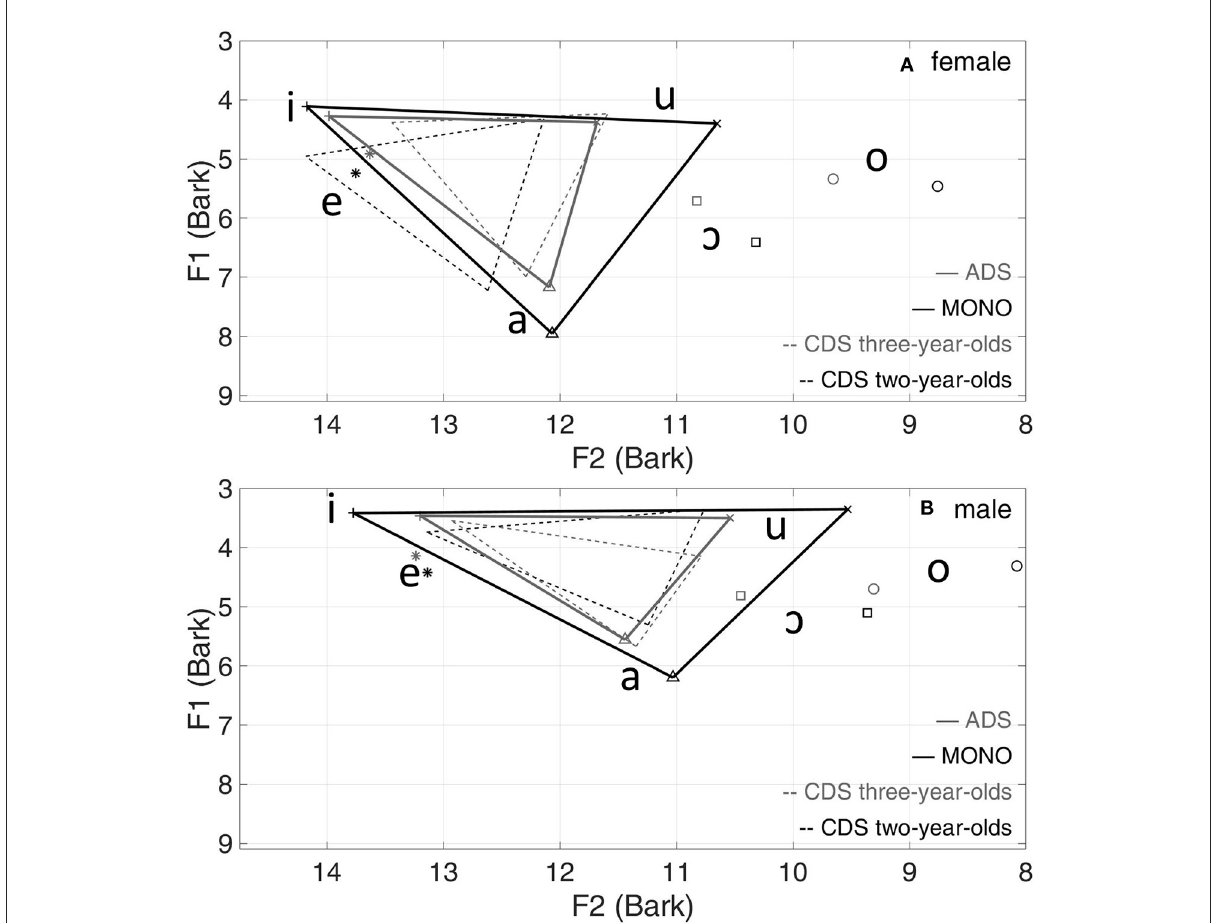
FIGURE2 Mean vowel formants (Bark) and triangles of all speakers in CDS, ADS and MONO for women (A) and men (B)